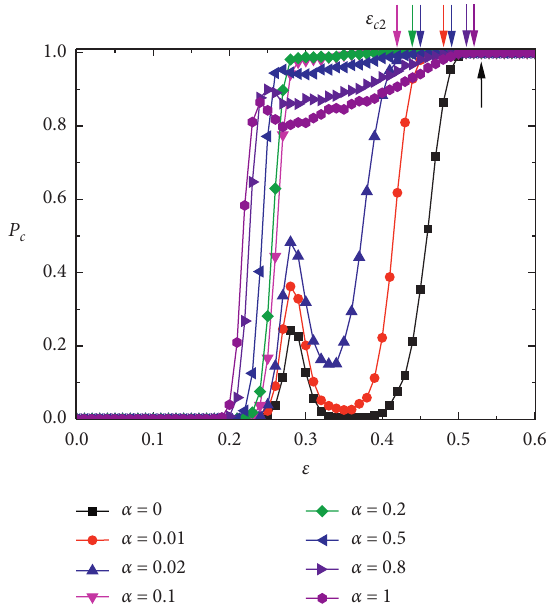
c as a function of